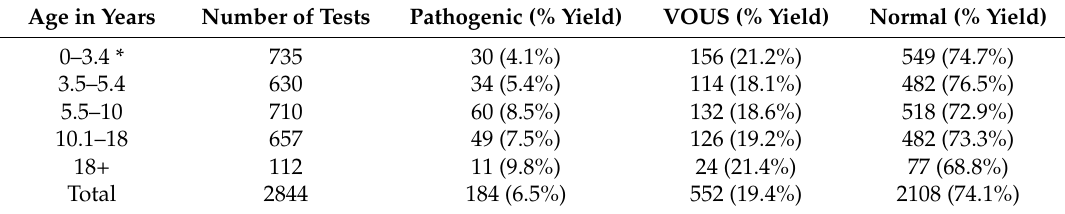
Table 5. Diagnostic yield by age in patients with ASD and other indications (610 (21.4%) females, 2234 (78.6%) males, Total n = 2844).